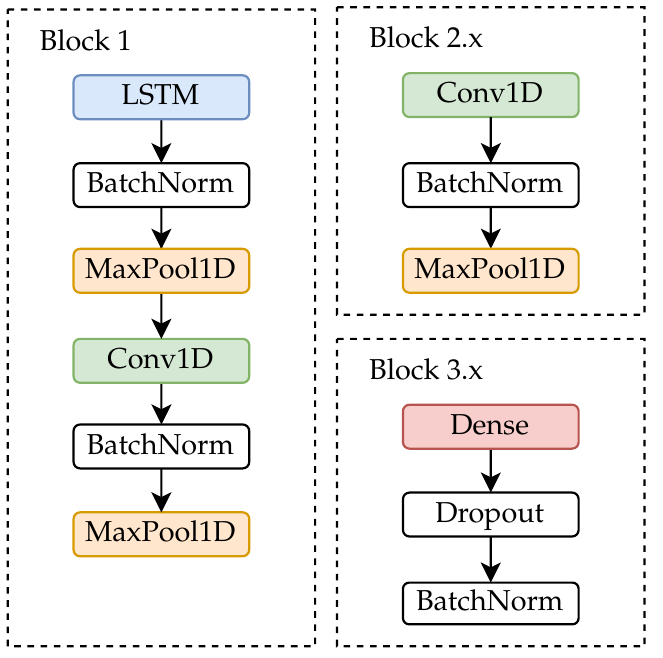
Figure 2. The blocks of the deep neural network. Details about the blocks and the layer parameters can be found in the Tables A1 to A6 in Appendix A.